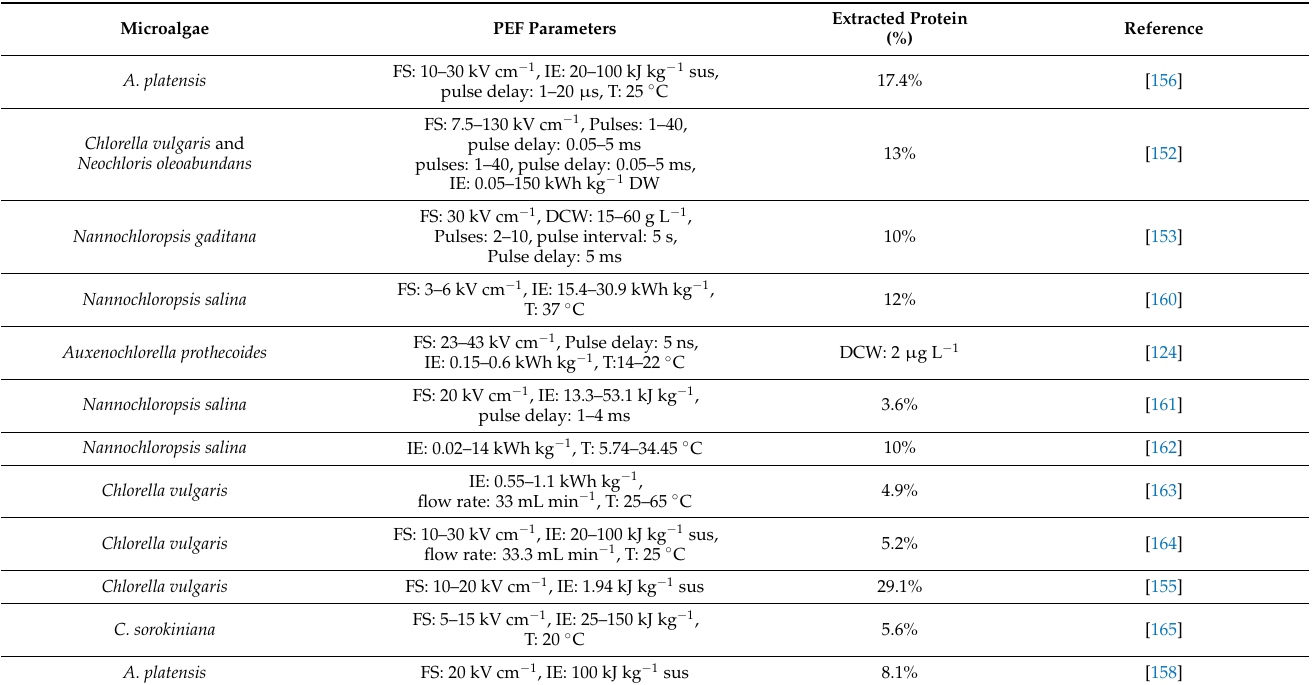
Table 5. Effect of parameter variation of PEF on protein extraction. DW: dry weight, DCW: dry cell weight; T: temperature; FS: field strength; IE: input